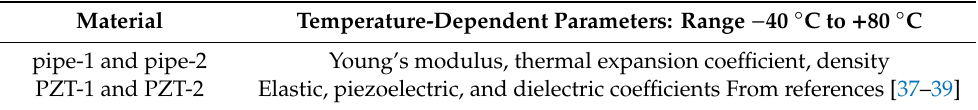
Table 2. Temperature-dependent parameters used in